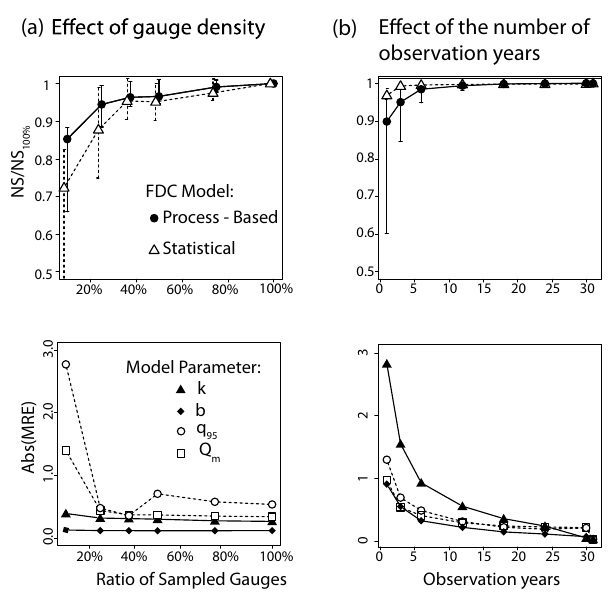
Figure 5. Sensitivity of models to data scarcity. (a) Cross-validation analysis showing the sensitivity of both models to a decreasing number of calibration gauges. (b) Resampling analysis of stream- flow observations in the Chepe Kohla ( N = 10000) catchment showing the effect of the number of observation years. In panels (a) and (b) , the effects on FDC prediction performances (top) are shown by plotting the ratio of calibration gauges sampled (or the number of observation years) against the relative Nash–Sutcliffe coefficient (with the NSC for the full set of available data as reference). The plot shows the median value for all iterations, and the error bars in- dicate the interquartile (25–75%) range. The prediction uncertain- ties of model parameters (bottom) are given in absolute values of relative prediction